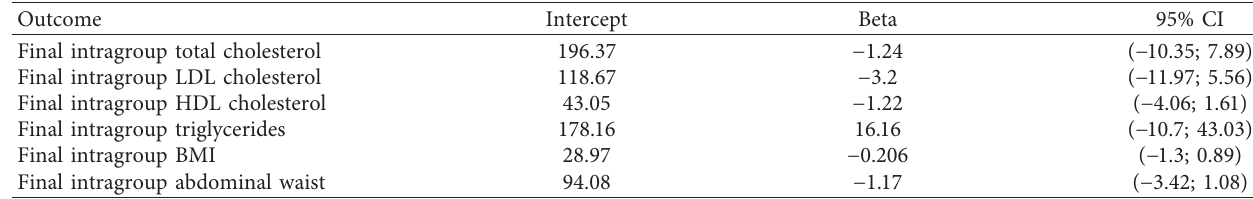
Table 3: Result with a one-stage approach showing the intercept and the beta values calculated with the variable cocoa consumption. Outcome